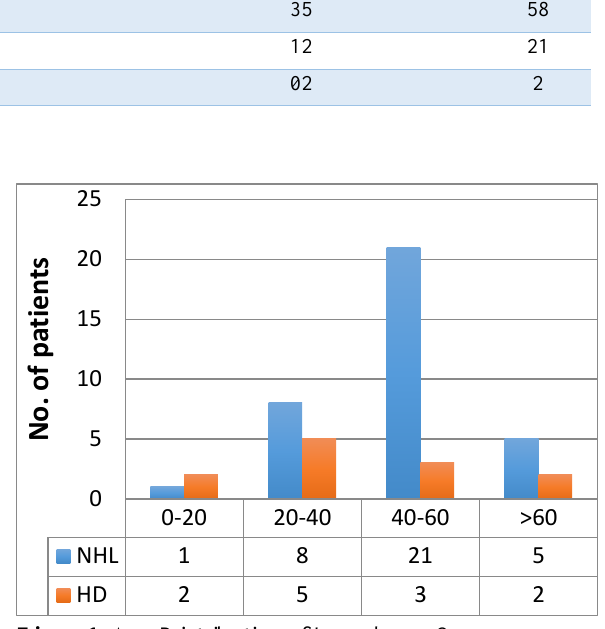
Figure1. Age Distribution of Lymphoma